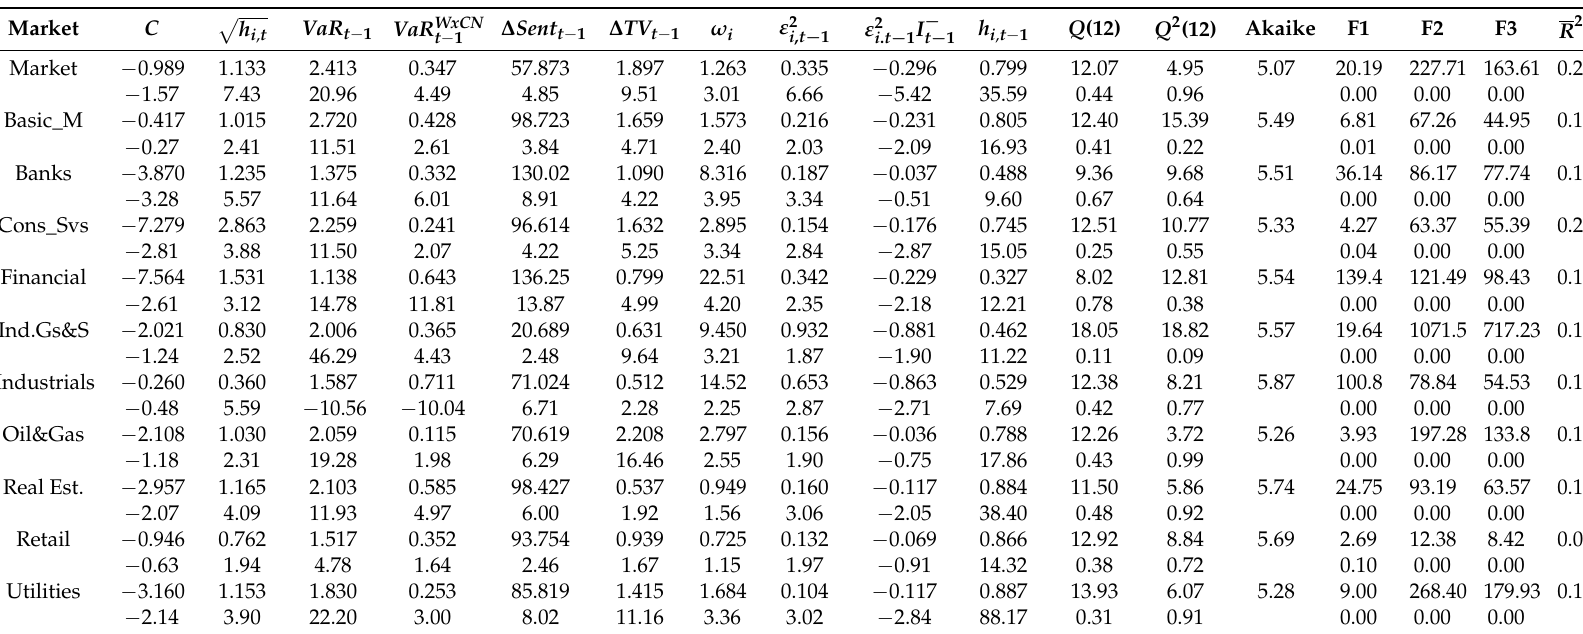
Table 6. Estimates of stock returns on local downside risk, world downside risk, sentiment, and liquidity with a GED-TARCH-M process.